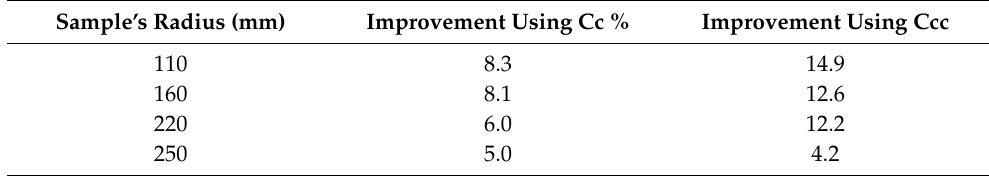
Figure 6. Comparison between each scenario in terms of compressive strength at 28 days. Table 10. The improvement of compressive strength using PVC tubes at 28 days. Table 10. The improvement of compressive strength using PVC tubes at 28 days.